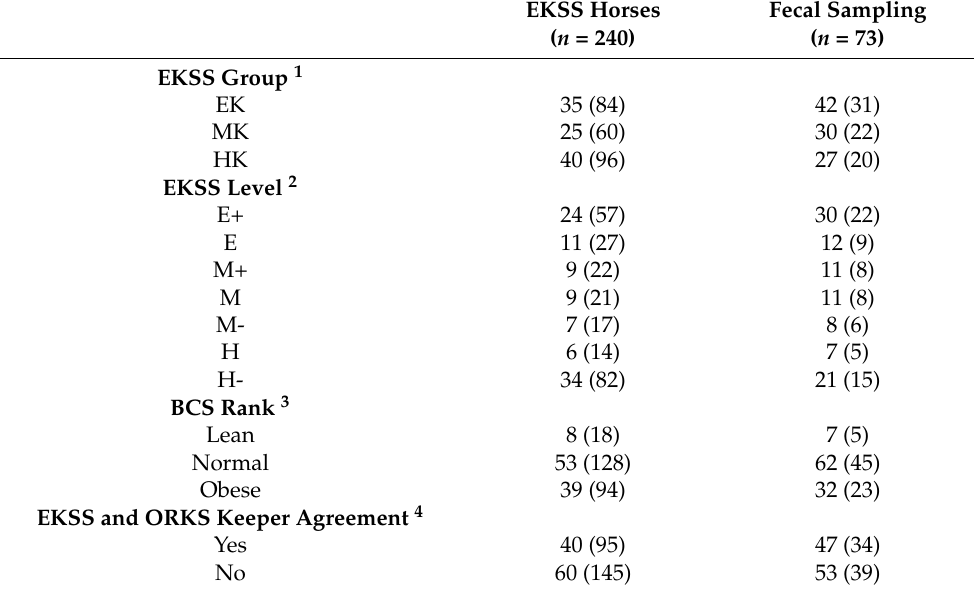
Table 1. Distribution of keeper statuses.